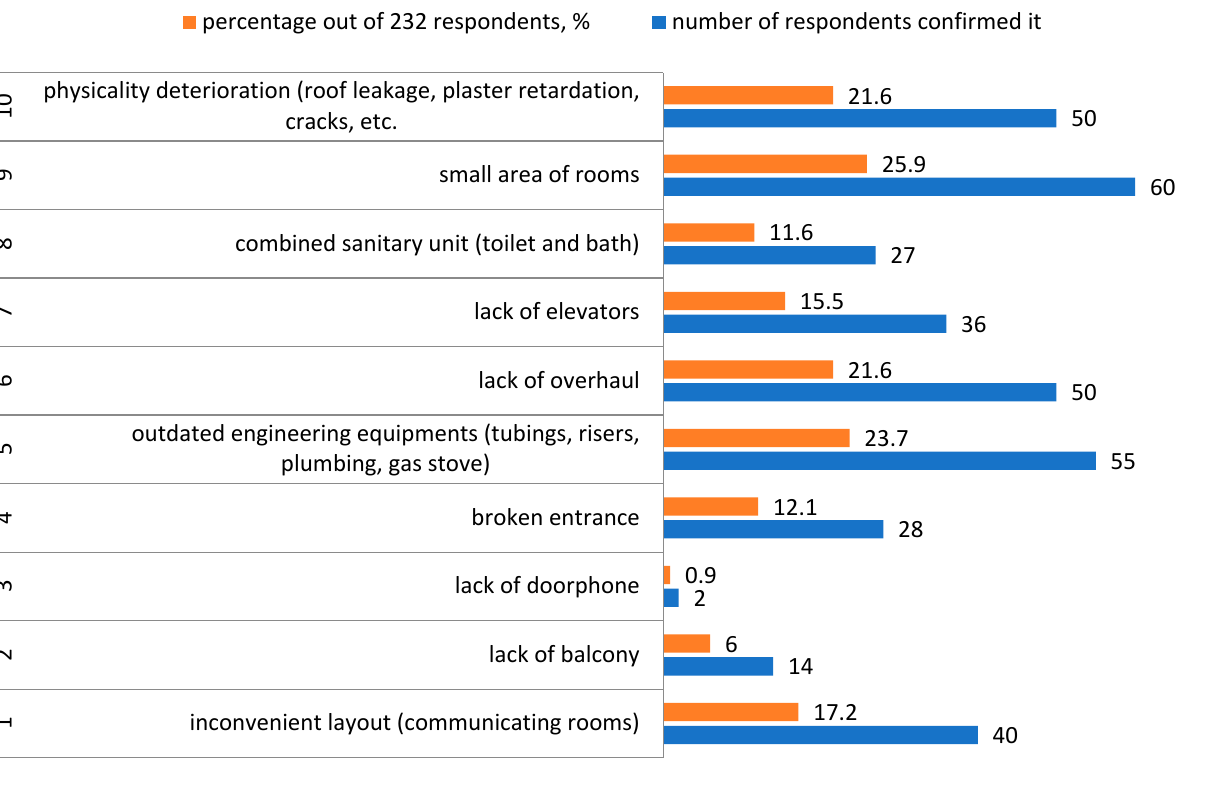
Figure 13. The results of the social survey (Author’s material).